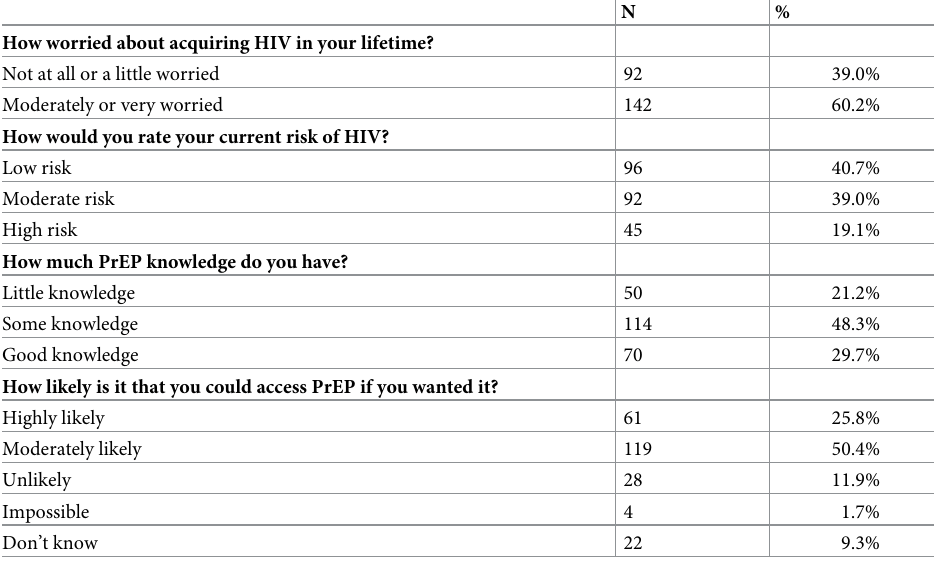
Table 4. HIV risk perception and PrEP perceptions of 236 PrEP eligible young men who have sex with men from an online survey in the U.S.